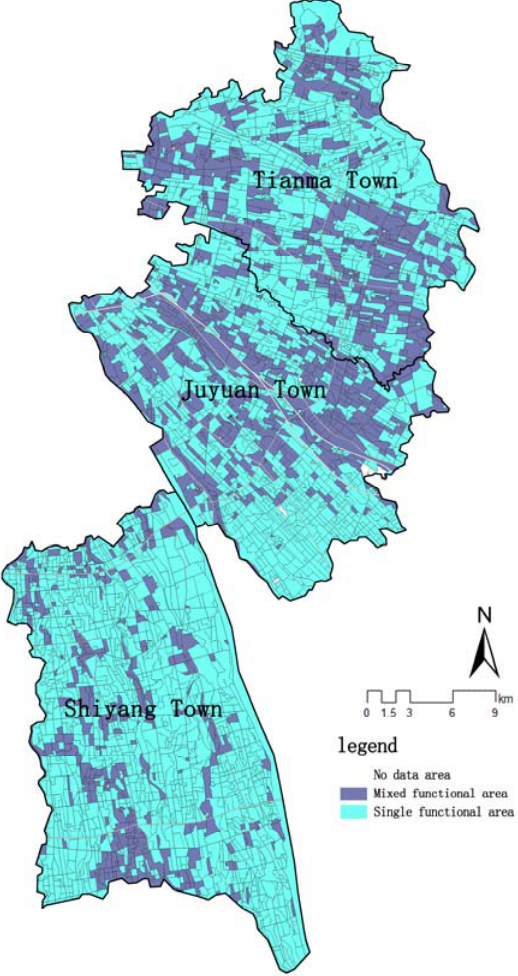
Figure 5. Proportions of mixed ‐ use functional